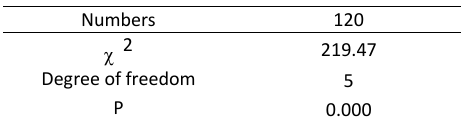
Table 9: Results of Friedman Test to prioritize ranks